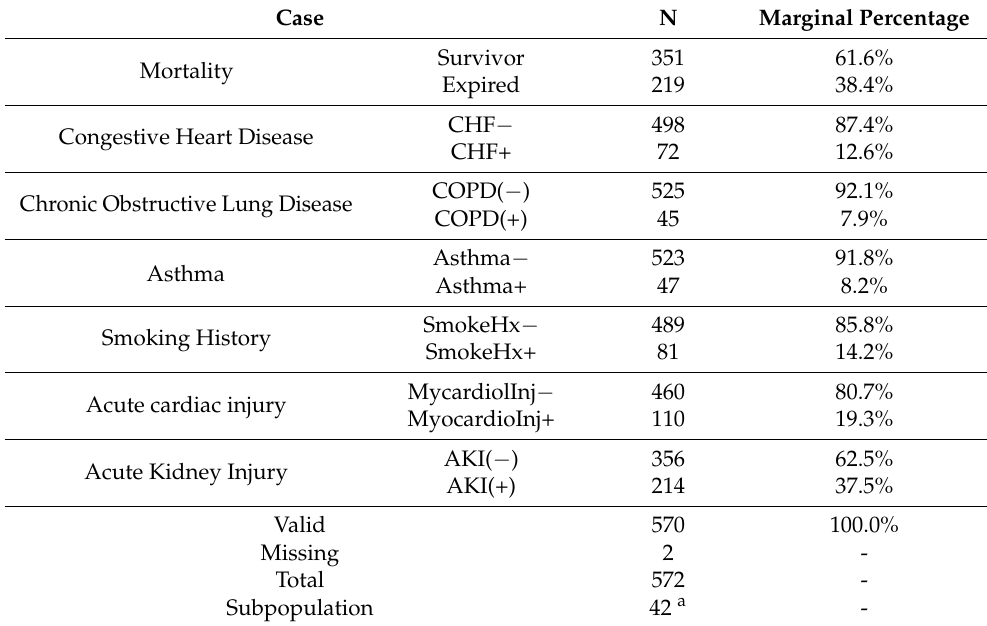
Table 2. Case processing summary.